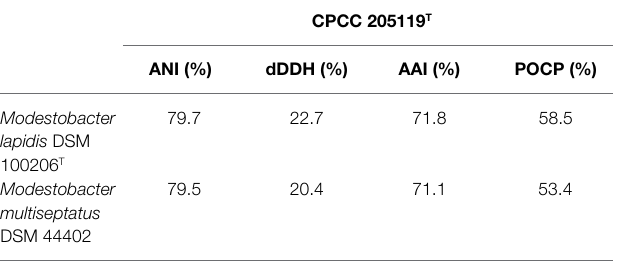
TABLE 1 | The values of ANI, dDDH, AAI, and POCP of the whole genome DNA assembly sequences between the strain CPCC 205119 T and the closest phylogenic neighbours.